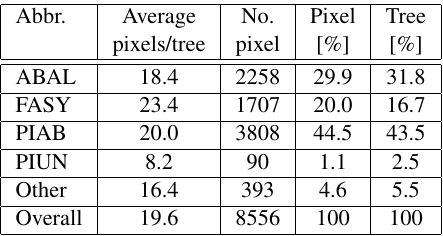
Table 3: Abbreviation, number and percentage of trees and